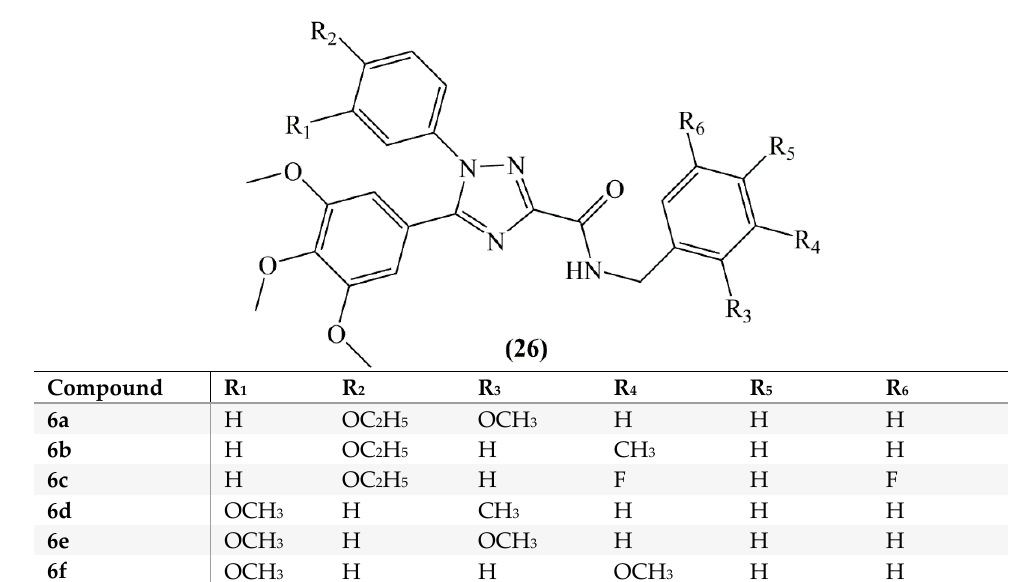
Figure 13. Structures of compounds 6a – 6f .